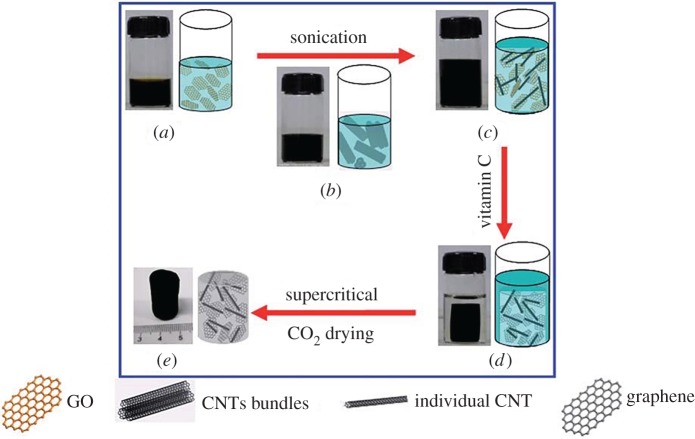
Schematic diagram for green synthesis of the graphene–CNT hybrid aerogels: (a) pre-dispersed GO solution; (b) pre-dispersed CNT suspension; (c) the mixture of GO and CNT after sonication; (d) the graphene–CNT hybrid hydrogel and (e) the graphene–CNT hybrid aerogel. In each subdivision graph, the left part is the digital photo of the real substance and the right part is the drawing photo of the imaginary substance. The CNTs employed here are directly applicable to pristine (MWCNTs) or acid-treated (c-MWCNTs) multi-wall CNTs. Adapted from Royal Society of Chemistry.